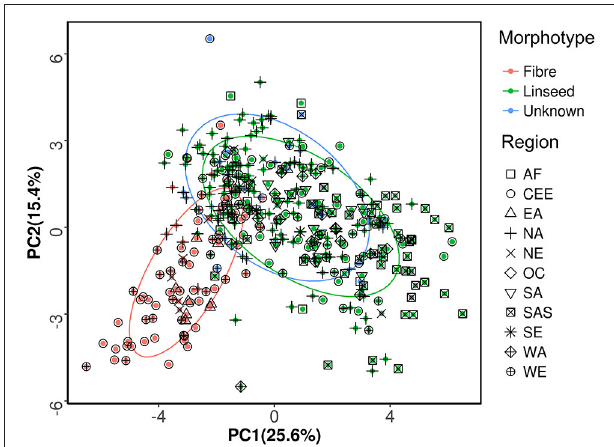
FIGURE 2 | Principal component analysis of the 391 flax accessions of the core collection. The first and second principal components, accounting for 41% of the total variance, are presented. The percentages in parentheses in the axis titles represent the variance explained by each of the two principal components. The ellipses represent the 95% confidence limits of fiber, linseed and unknown